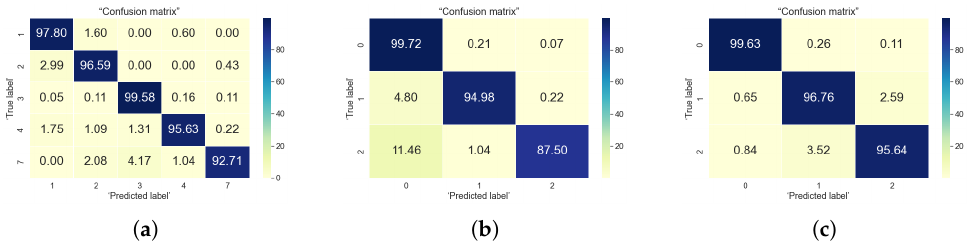
Figure 13. Confusion matrix for XGBoost algorithm using indoor data. ( a ) User classification; ( b ) UCLA based classification; ( c ) Lubben-based classification.